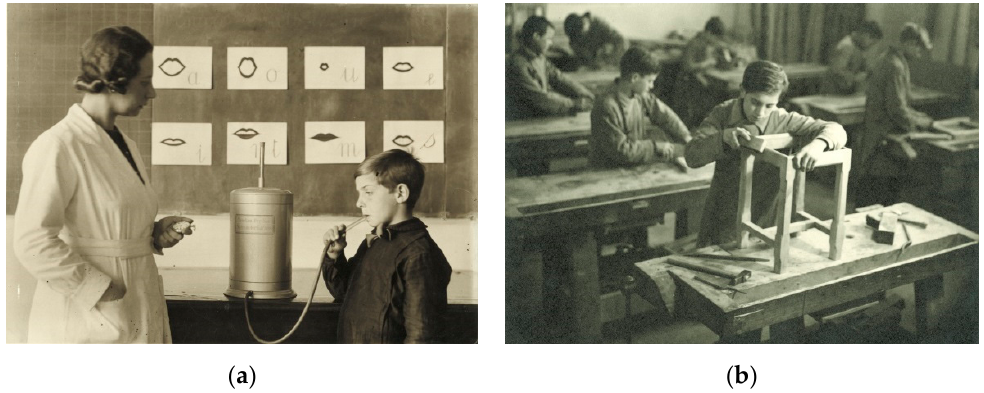
Figure 1. ( a ) Medical aspects (ASPG, file 3488); ( b ) Lab aspects (ASPG, file